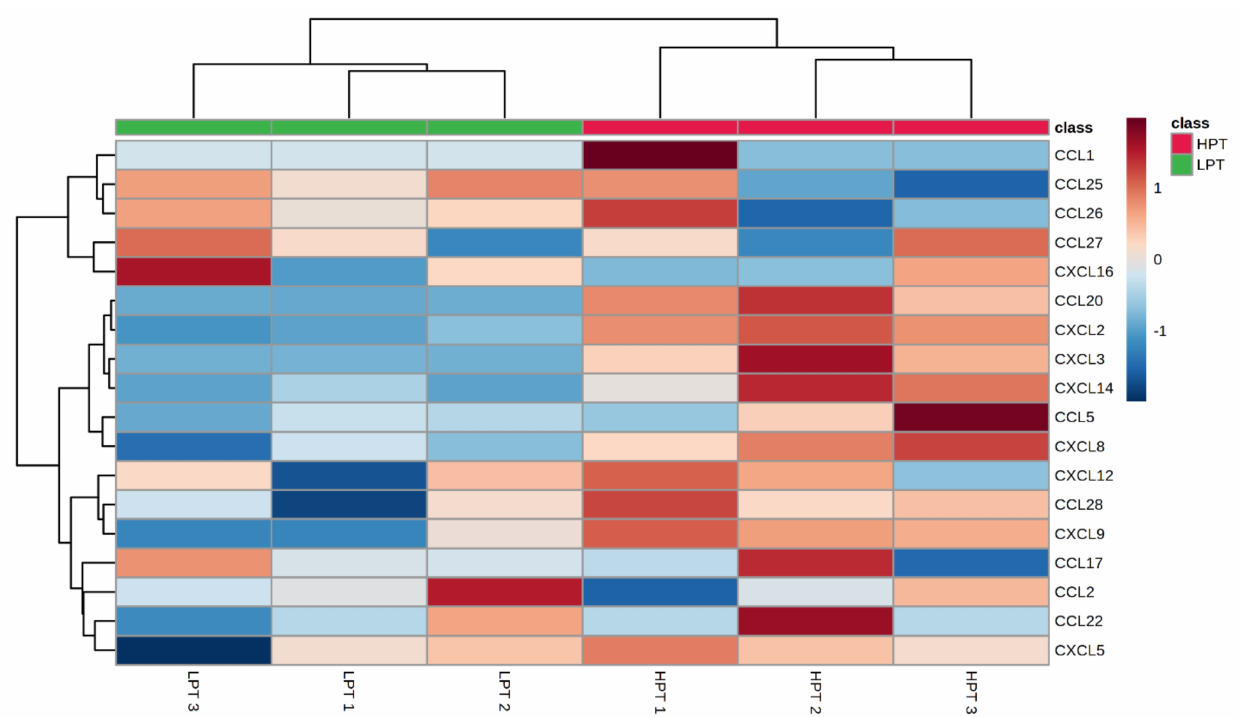
Figure 4. Dendrogram of differential expressed genes involved the chemokines. The log 10 (FPKM+1) value was clustered. Blue represents the low-level genes, and red represents the high-level genes. The color from blue to red represents that the gene expression level is higher and